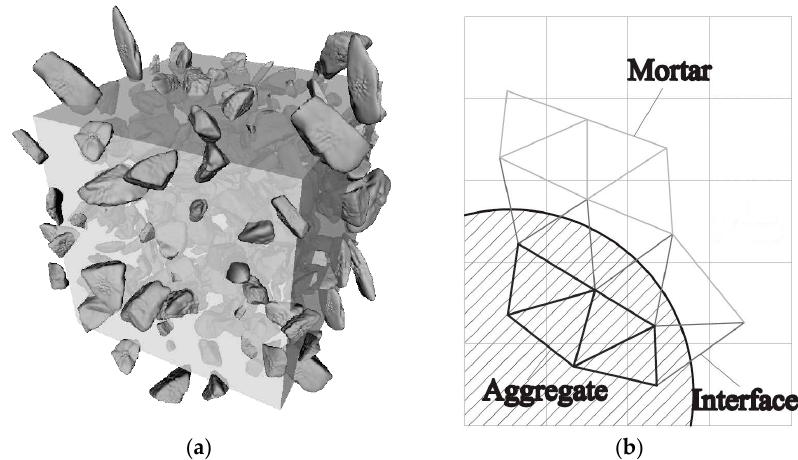
Figure 2. Including material mesostructure of the concrete substrate ( a ) aggregates in the concrete substrate generated by Anm model [32]; ( b ) two-dimensional overlay procedure for generation of the lattice model in the interface zone between aggregate and substrate mortar (ITZ).